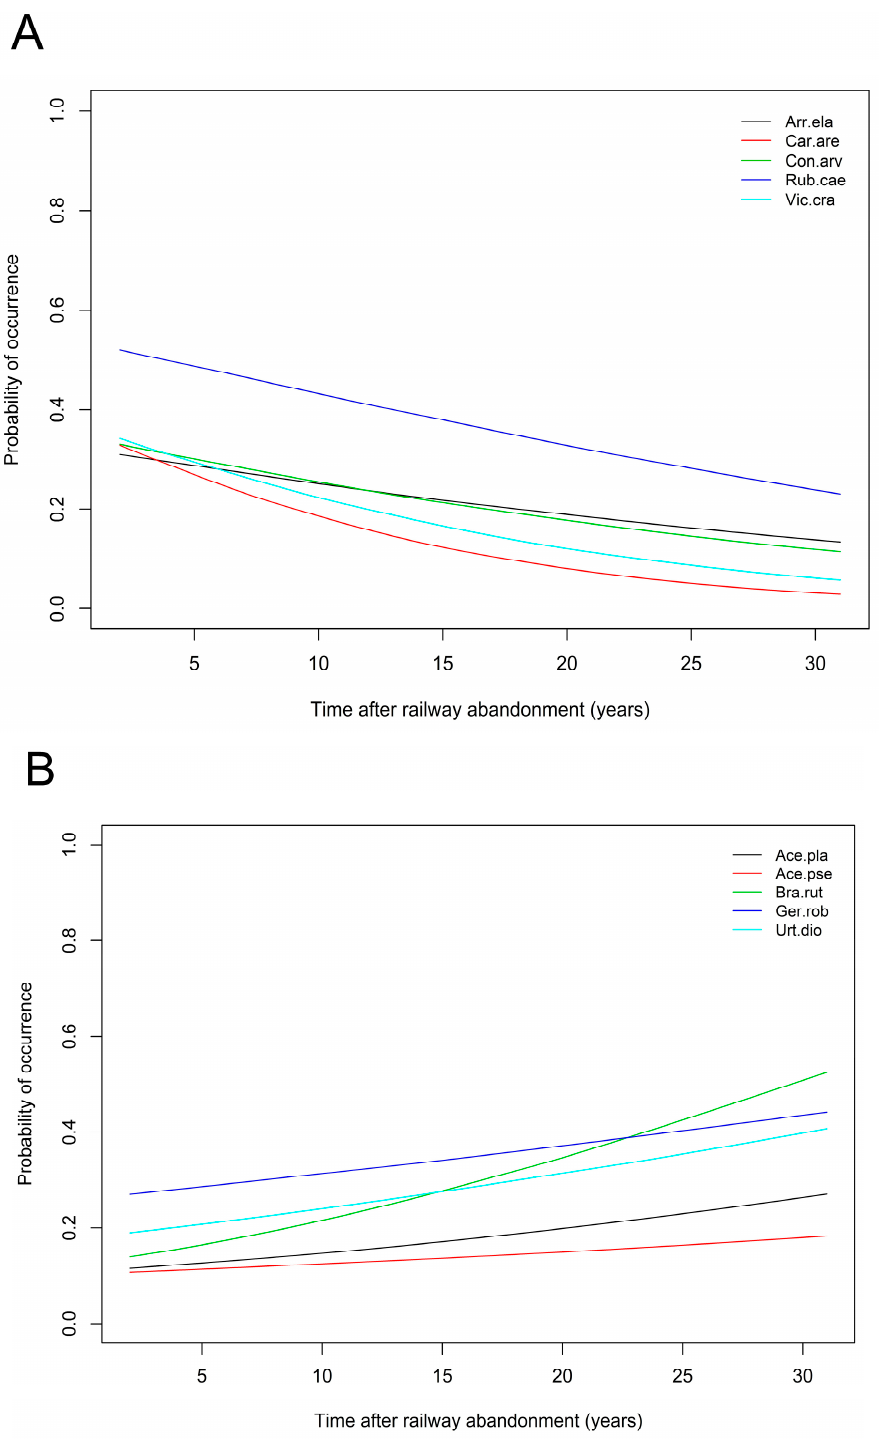
Figure 3. Species response curves for plant species from analyzed plots representing probability of occurrence. The curves exemplify species whose frequency of occurrence over time decreases ( A ) or increases ( B ). Explanations: see section Materials and Methods (subsection: